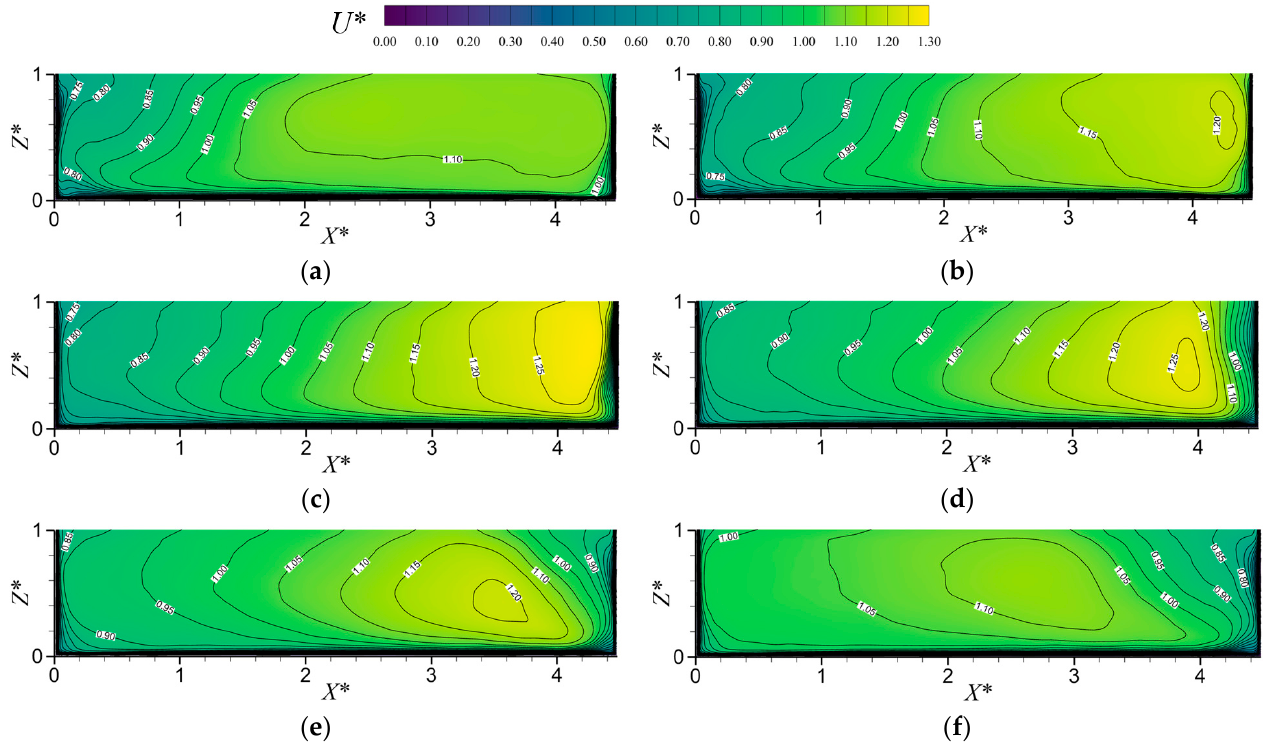
Figure 7. Normalized streamwise velocity U* (from left to right denotes from inner bank to outer bank). ( a ) Section #01; ( b ) Section #02; ( c ) Section #03; ( d ) Section #04; ( e ) Section #05; ( f ) and Section #06.